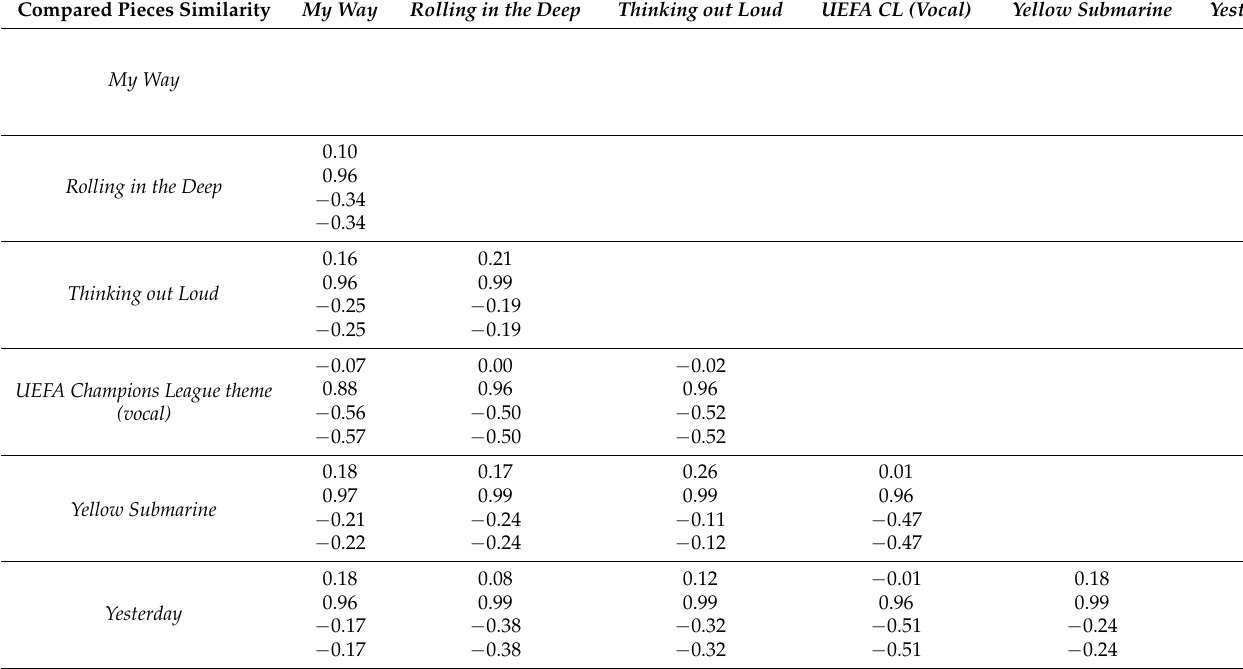
Table 4. Comparison of tracks from the popular music